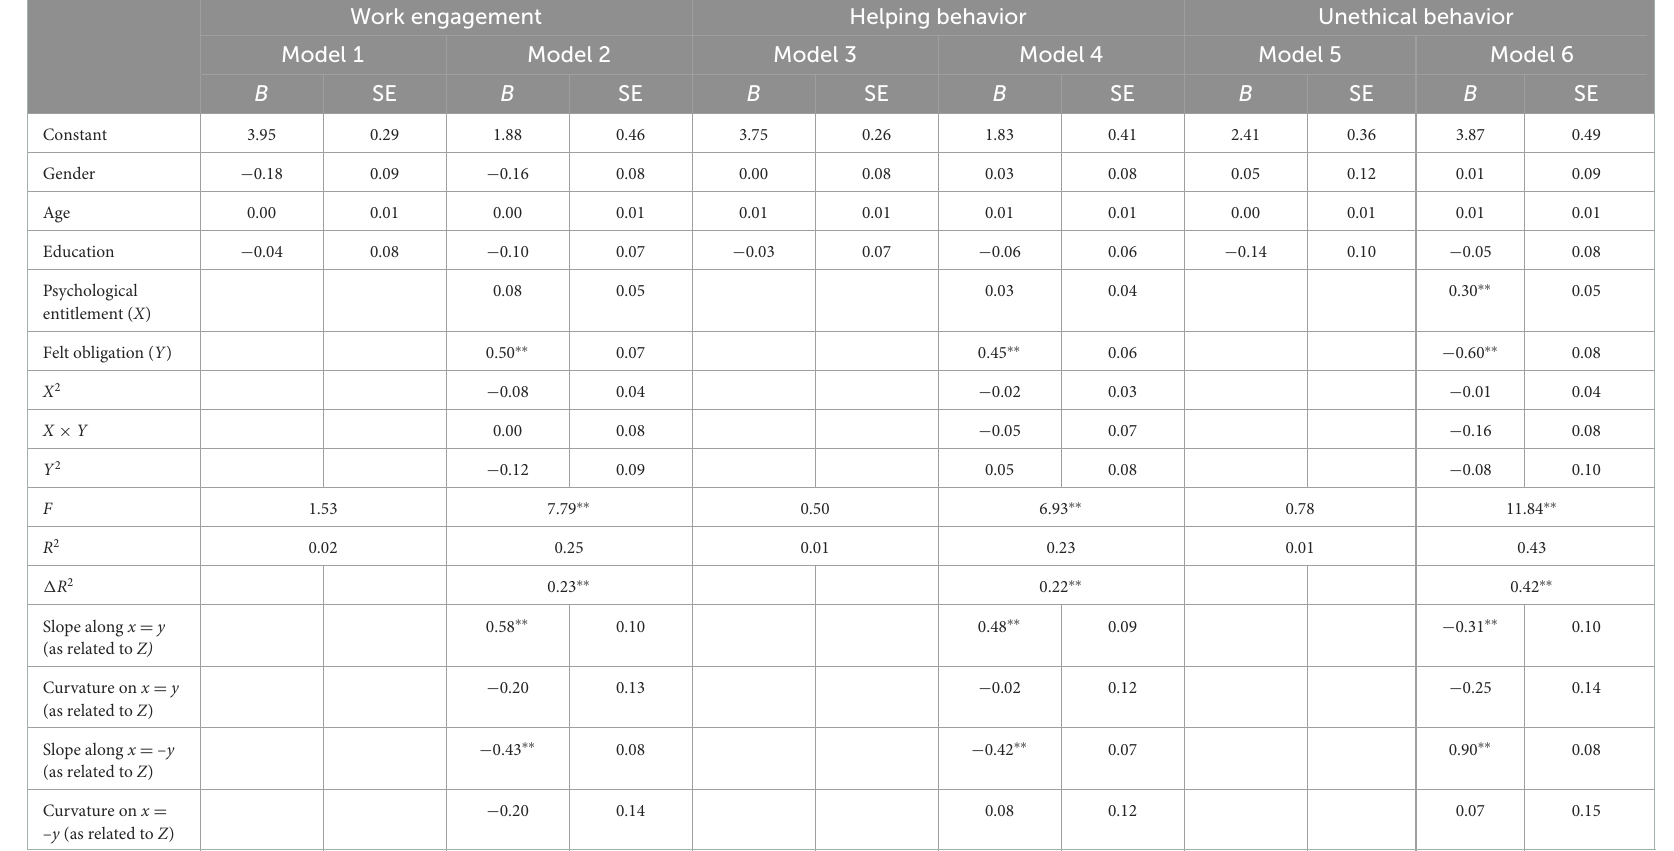
TABLE 3 Results of polynomial regression with response surface